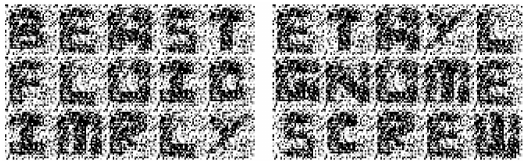
Figure 12. An example of a test set with noisy incongruent context for the CINET(4) classifier.